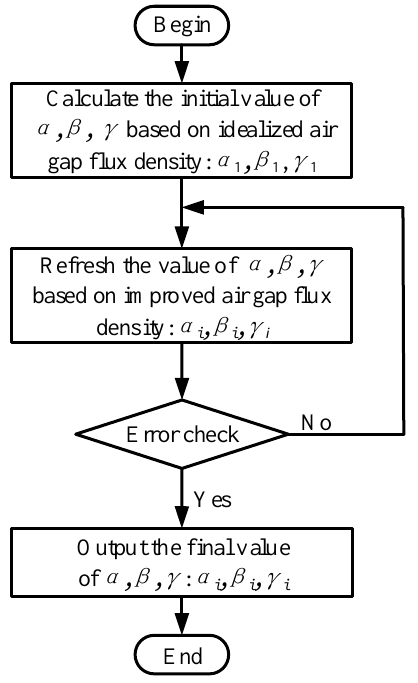
Figure 11. The optimization design process.